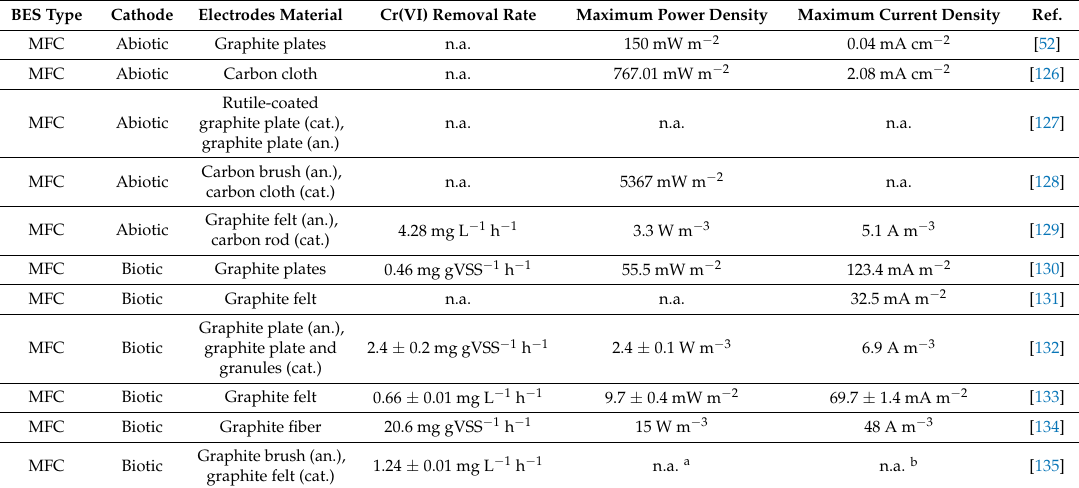
Table 3. Chromium removal using